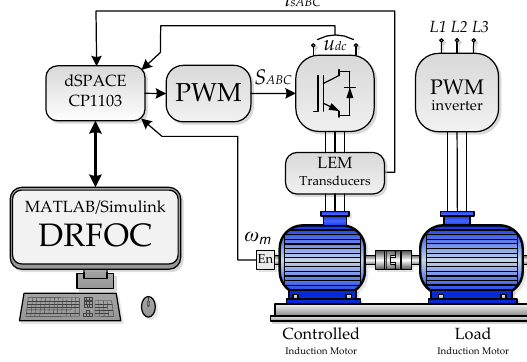
Figure 6. The structure of the drive system used for experimental research.